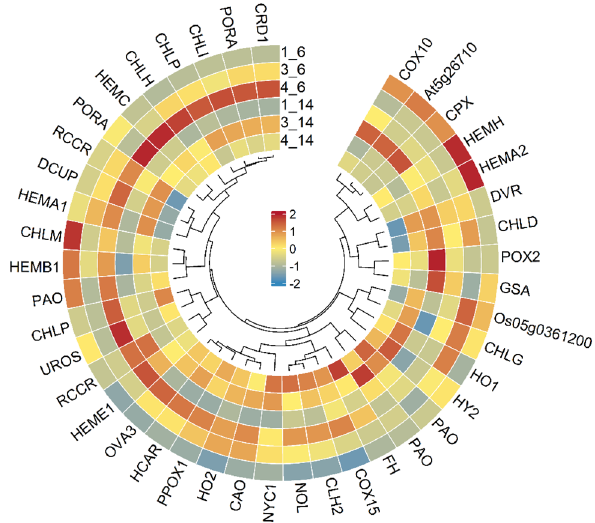
Figure 7. Heat map representation and hierarchical clustering of structural genes involved in porphyrin and chlorophyll metabolism in “B-14” and “B-6” melon cultivars at different growth